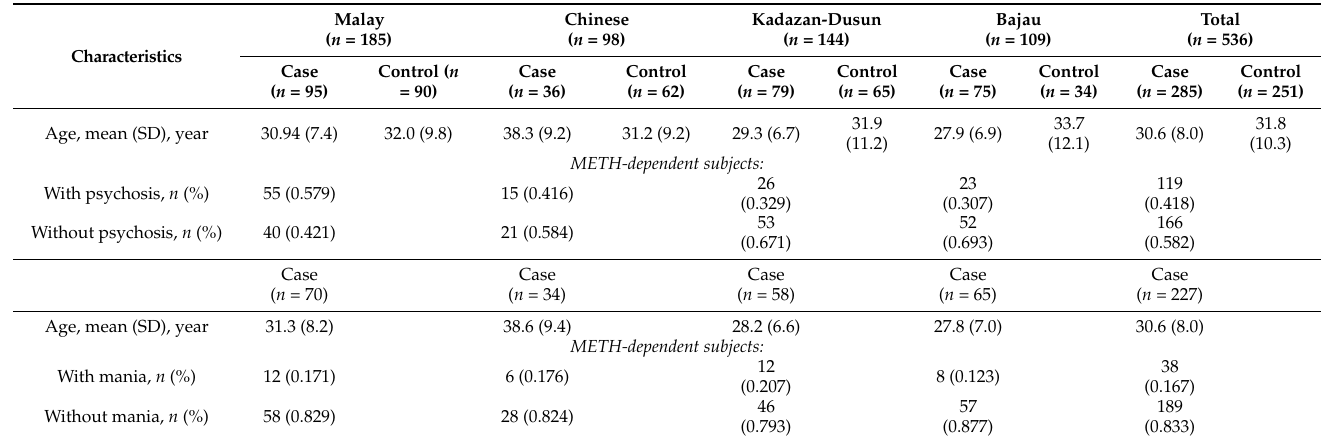
Table 1. Demographic data for METH dependent and control subjects.